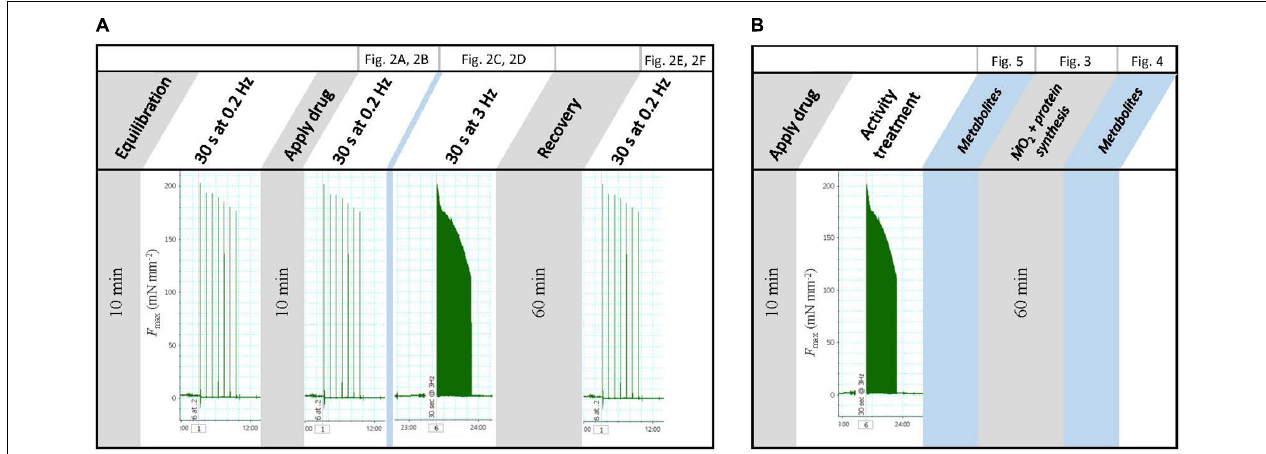
FIGURE 1 | Schematic of experimental design. (A) Contractility study. (B) ˙M O 2 , protein synthesis, and metabolite levels.